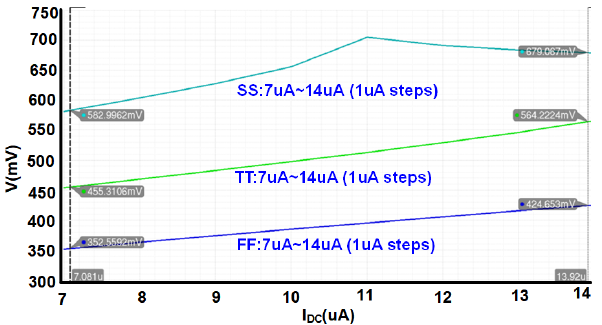
Figure 5. Simulation results of the digitally controllable bias voltage generator for an example voltage, in different corner cases and with different I B reference currents.